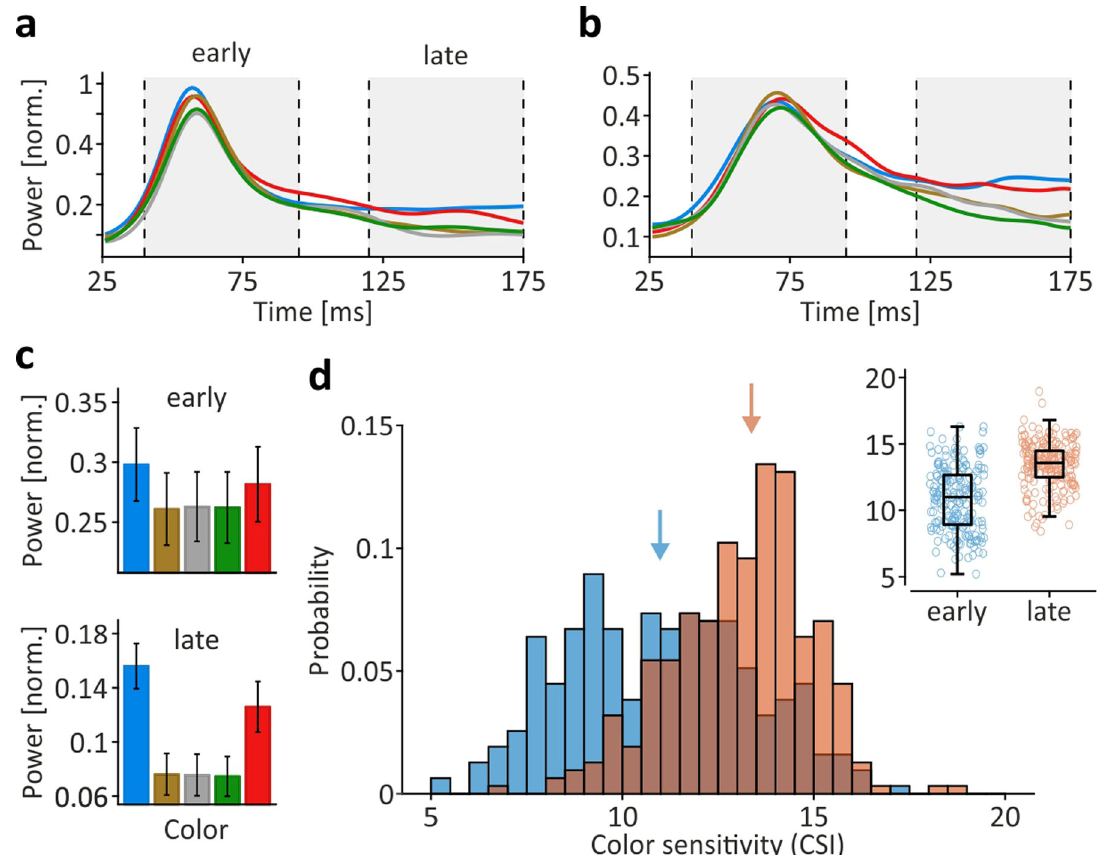
Fig. 6 EFP modulation as function of color. a – b Time course of mean power in ROC-selected frequency range ( a M2, 47 – 96 Hz; b M1, 42 – 145 Hz) in response to differently colored stimuli. Line color indicates stimulus color. Gray-shaded areas indicate response periods during transient stimulus onset ( ‘ early ’ ) and sustained ( ‘ late ’ ) activation. c Power in ROC-selected time-frequency range, averaged over all electrodes, during early and late response periods. Bar color indicates stimulus color. Error bars, SEM. Individual data points are shown in Supplementary Fig. 3. d Color index distribution during early (blue) and late (orange) response periods. Color index CSI is independent of absolute activation. Arrows indicate median CSI during early and late responses. Inset shows CSI of individual electrodes, boxes indicate 25th and 75th percentile including median, whiskers indicate interquartile